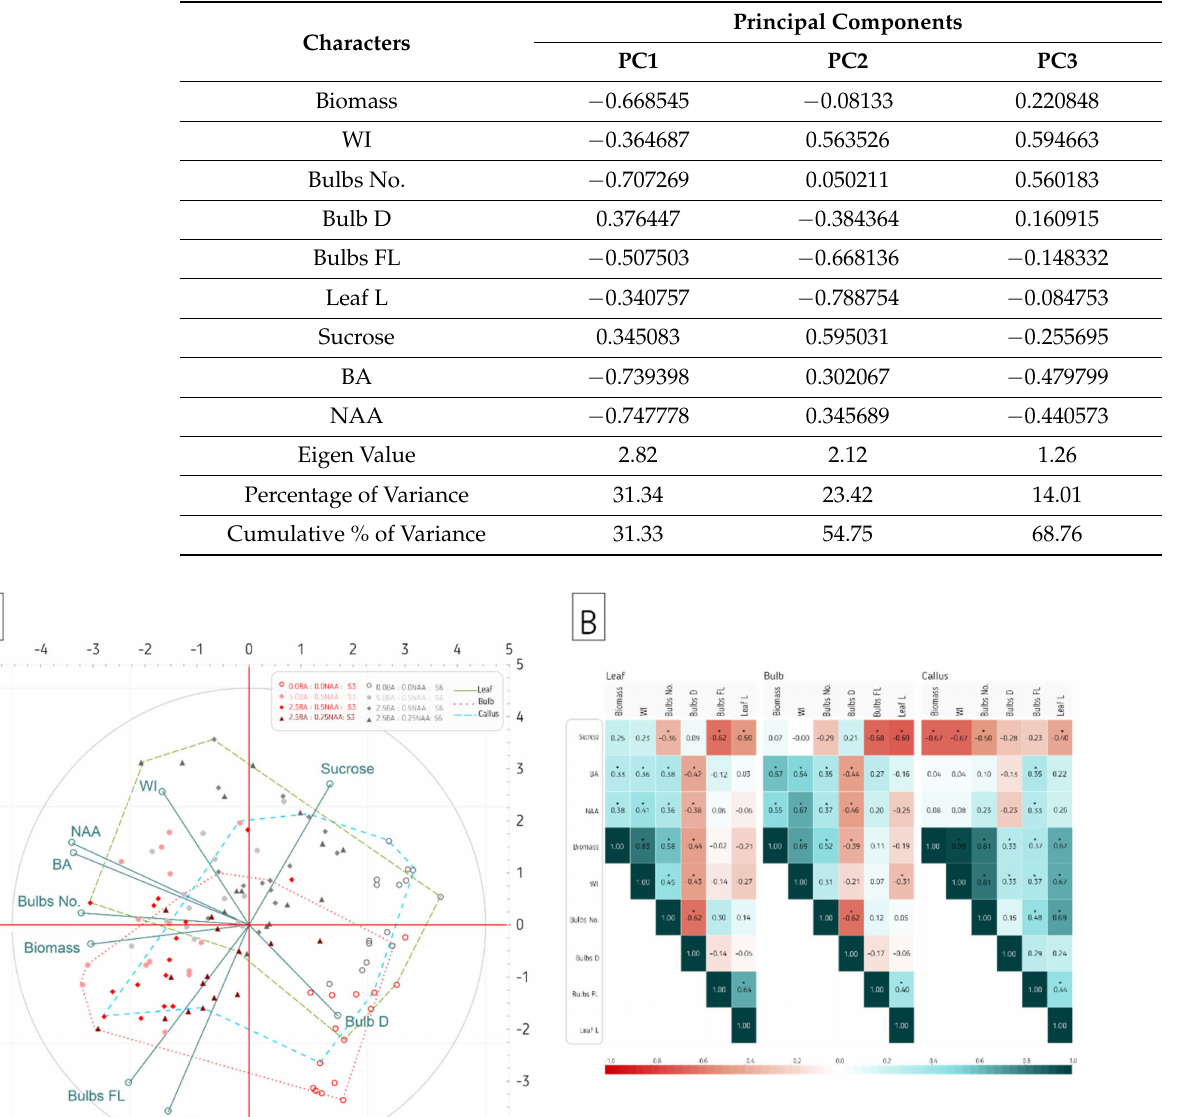
Table 3. Component loadings of 9 variables, eigen values, proportion of total variability represented by the first three principal components (PCs) and cumulative variability.